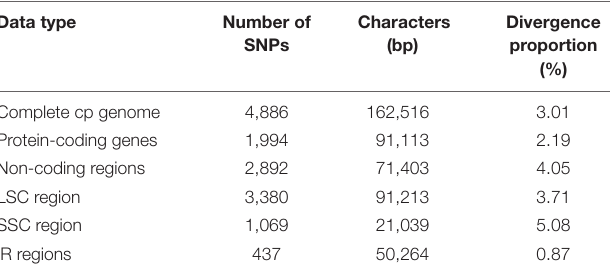
TABLE 3 | Summary of the single nucleotide polymorphisms (SNPs) found in the six Cornales cp genomes.